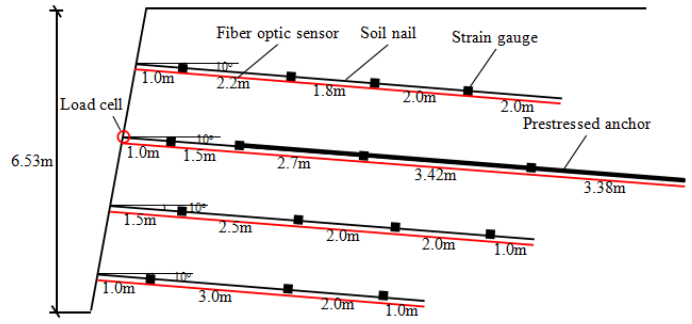
Figure 9. Location of instruments for testing set No. 4.